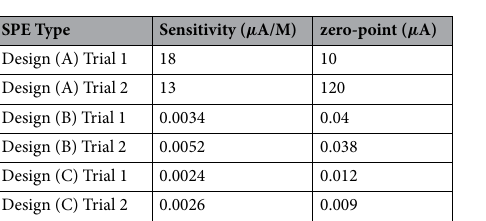
Table 2. The best fit line of oxidation peak measurements with all three designs using type (C)